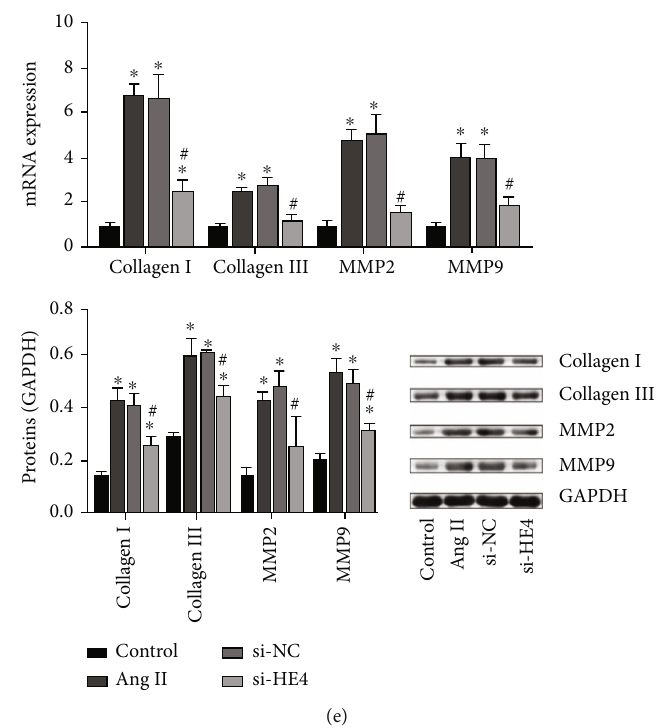
Figure 4: Knockdown of HE4 inhibited myocardial fi broblast fi brosis. (a) Identi fi cation of primary rat myocardial fi broblast ( × 400, 25 μ m). (b) Expression of HE4 was tested by qRT-PCR and Western blot. (c) Acta2 expression was tested by qRT-PCR. (d) IF determined α -SMA expression ( × 400, 25 μ m). (e) qRT-PCR and Western blot were utilized to detect collagen I, collagen III, MMP2, and MMP9 levels. ∗ P < 0 : 05 vs. control; # P < 0 : 05 vs.